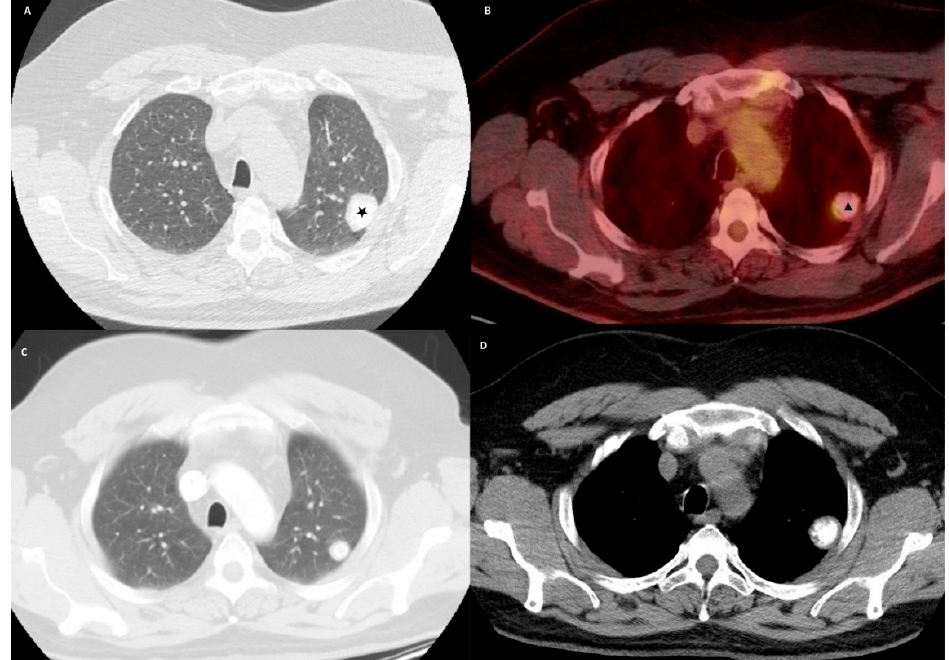
Figure 1. ( A ) is a computed tomography of chest in an axial plane showing a pleural based left upper lobe mass (denoted by a star), ( B ) is a positron emission tomography of chest in an axial plane showing mild avidity in the left upper lobe mass, ( C ) is computed tomography of chest in axial plane showing left upper lobe nodule, which is smaller in size ten years back, and ( D ) shows the left upper lobe nodule with central calcification.